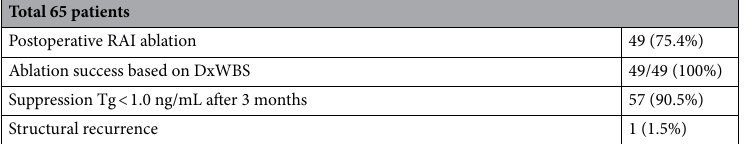
Table 4. Treatment outcomes of re-do robotic operation. Data are expressed as patient number (%). Average follow up duration 50.7 ± 37.1 months (range 3–121). RAI radioactive iodine, DxWBS diagnostic whole body scan, Tg